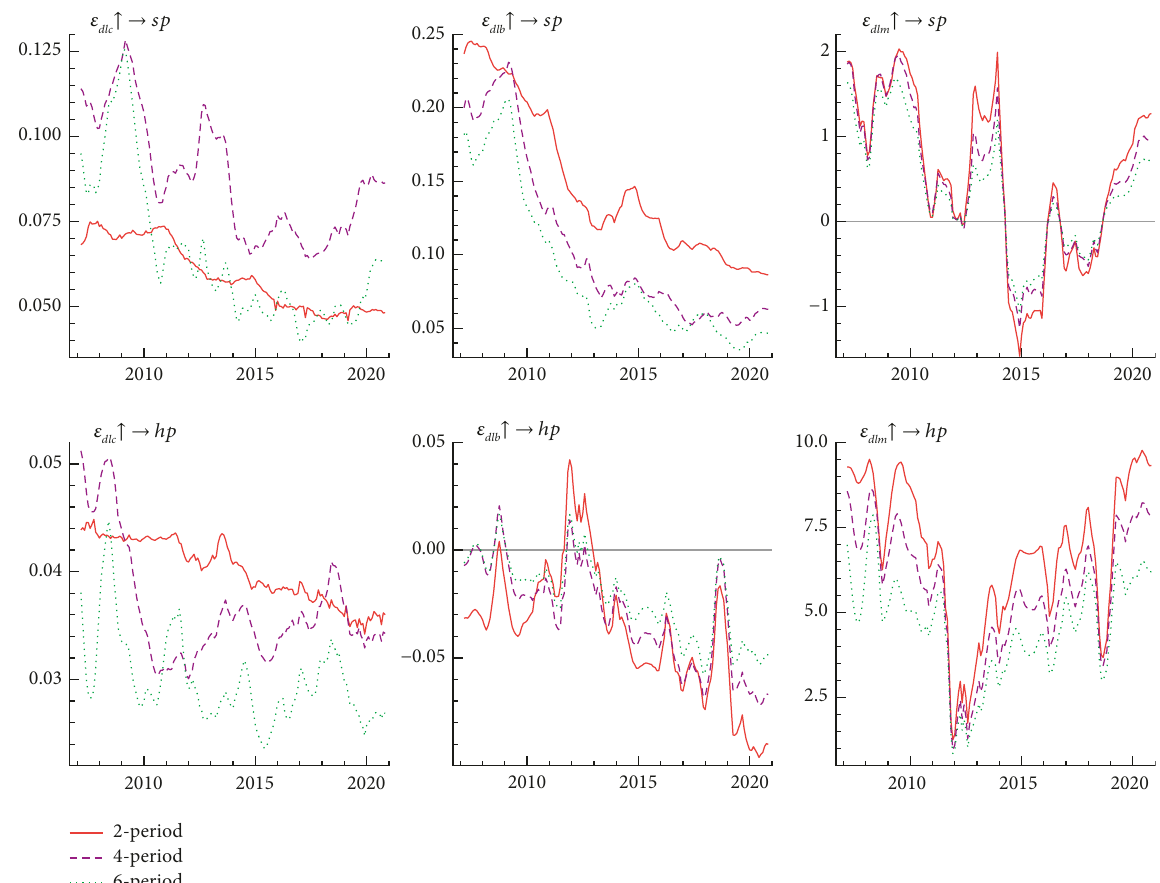
Figure 6: The impulse responses of liquidity to asset price volatility with an equal